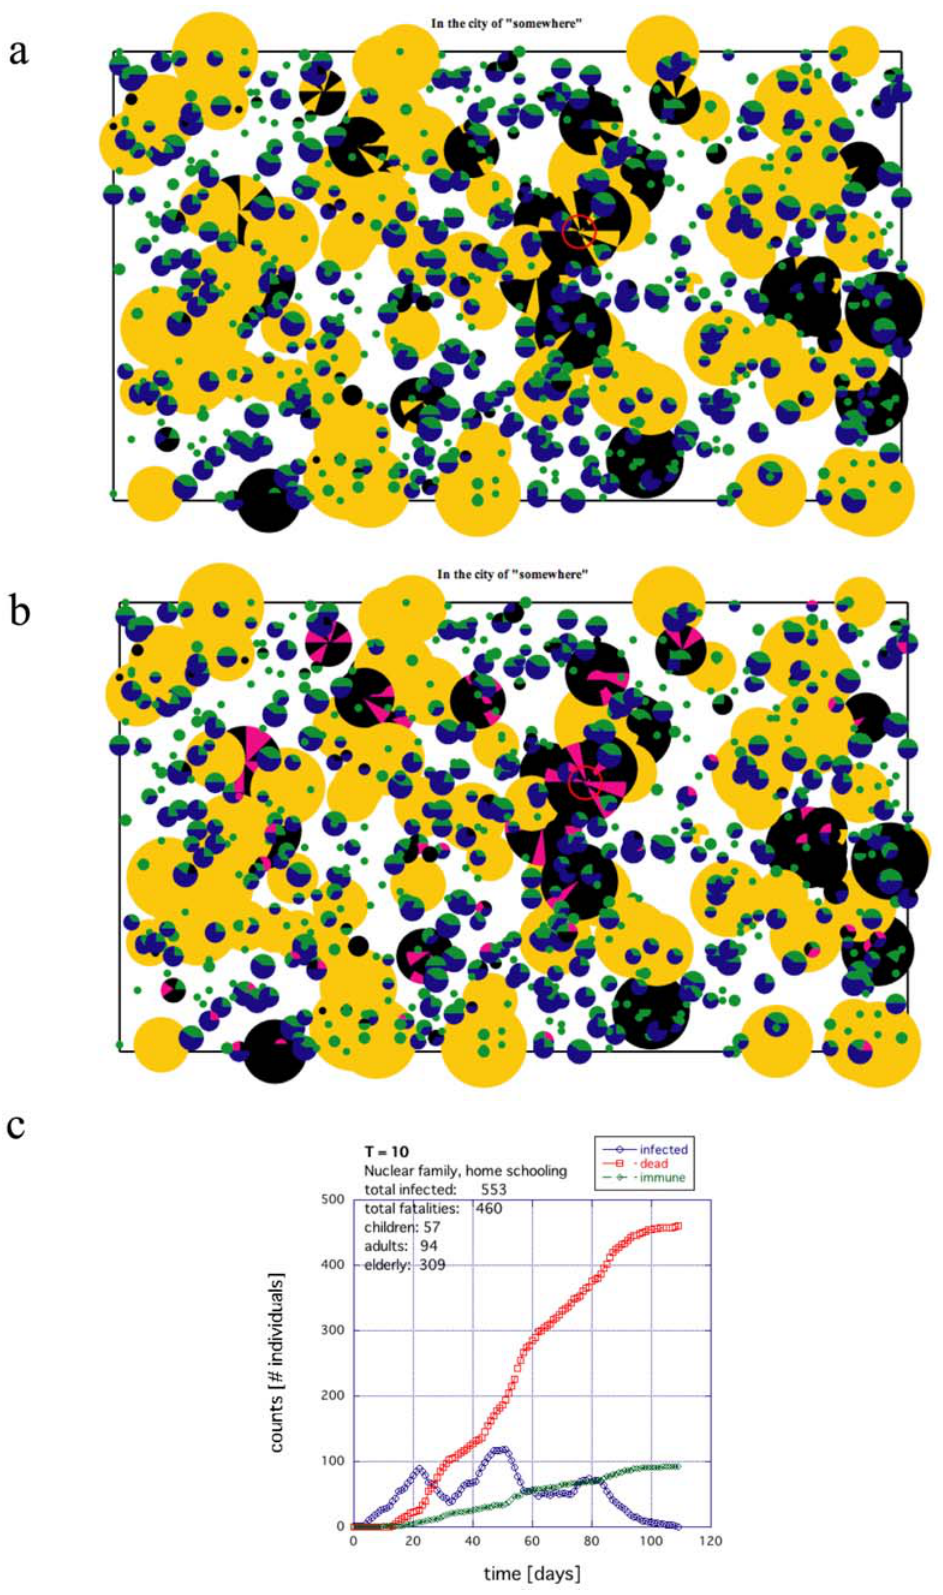
Figure 7. An example of the death toll for the same nuclear family society as in Figure 5 if home schooling is introduced (all other parameters held constant). (a) Surviving population whether infected or not where black indicates deceased. (b) Population of infected individuals both deceased (black) and recovered (magenta). (c) Time histogram of the rate of infection, death and recovery.